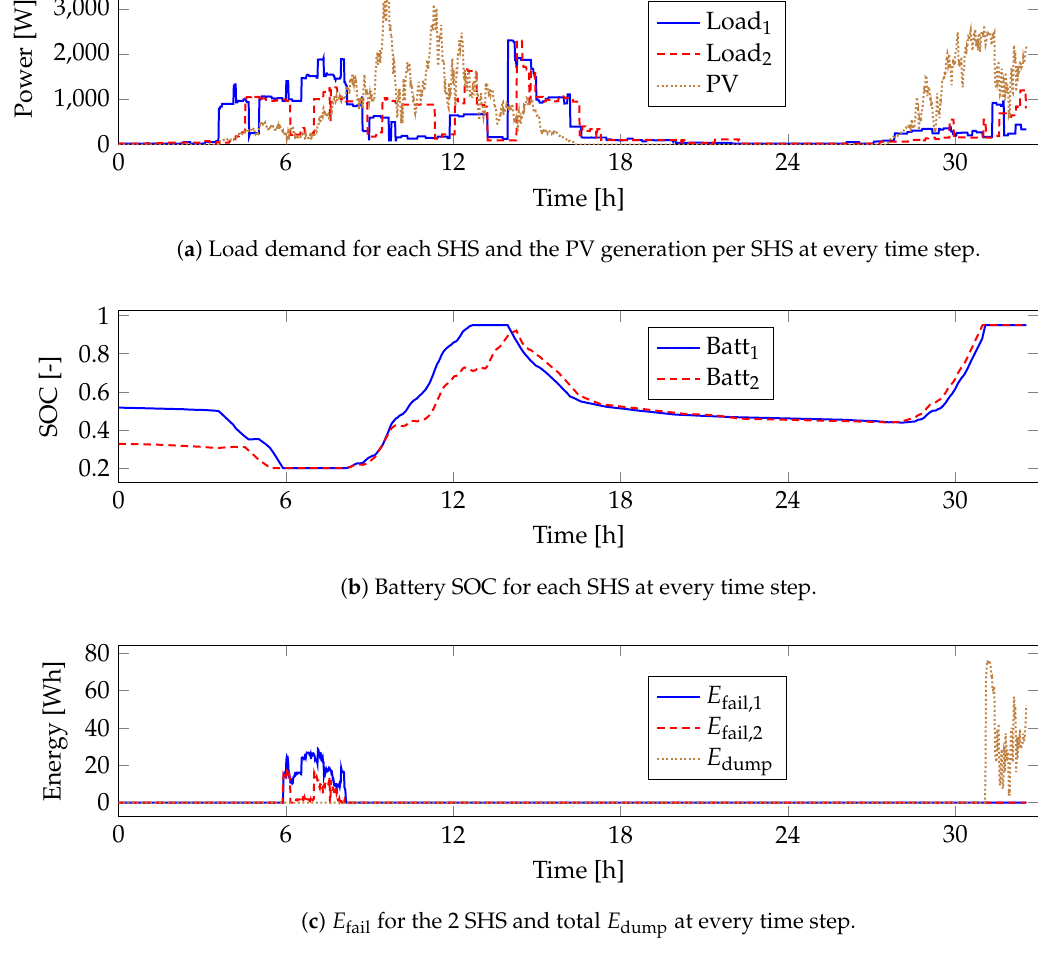
Figure 10. A snapshot capturing the energy sharing between two interconnected SHSs over a period of 32 h during the 1 year of